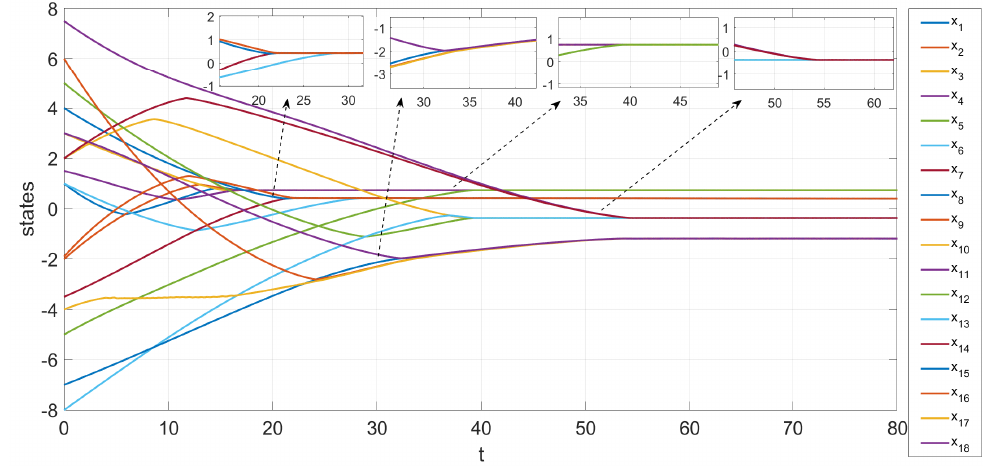
Figure 3. α = 0.25.